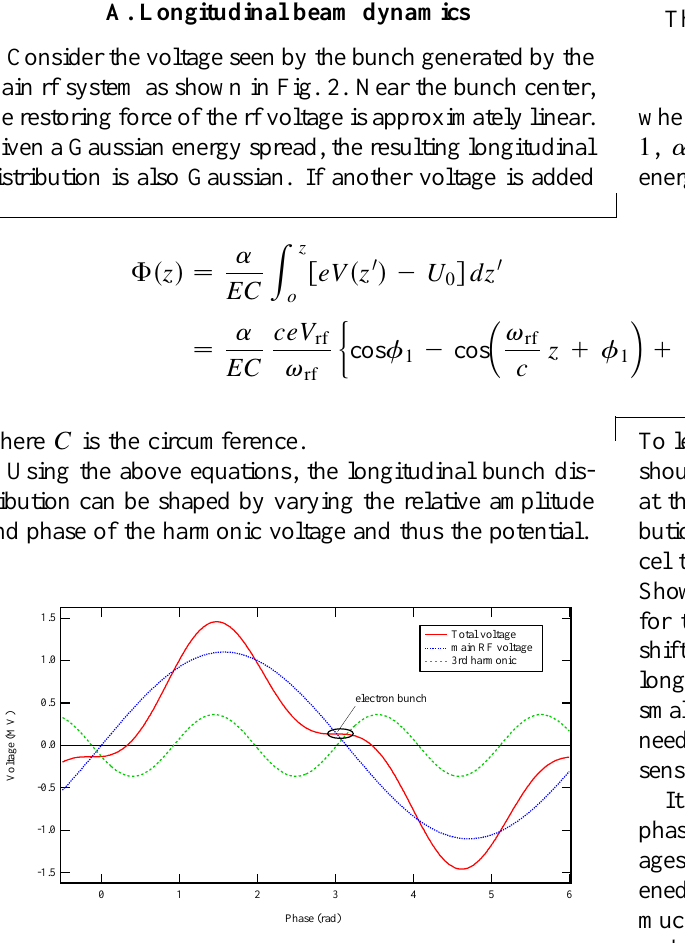
FIG. 2. (Color) rf voltage seen by the bunch for main rf and higher harmonic cavities.